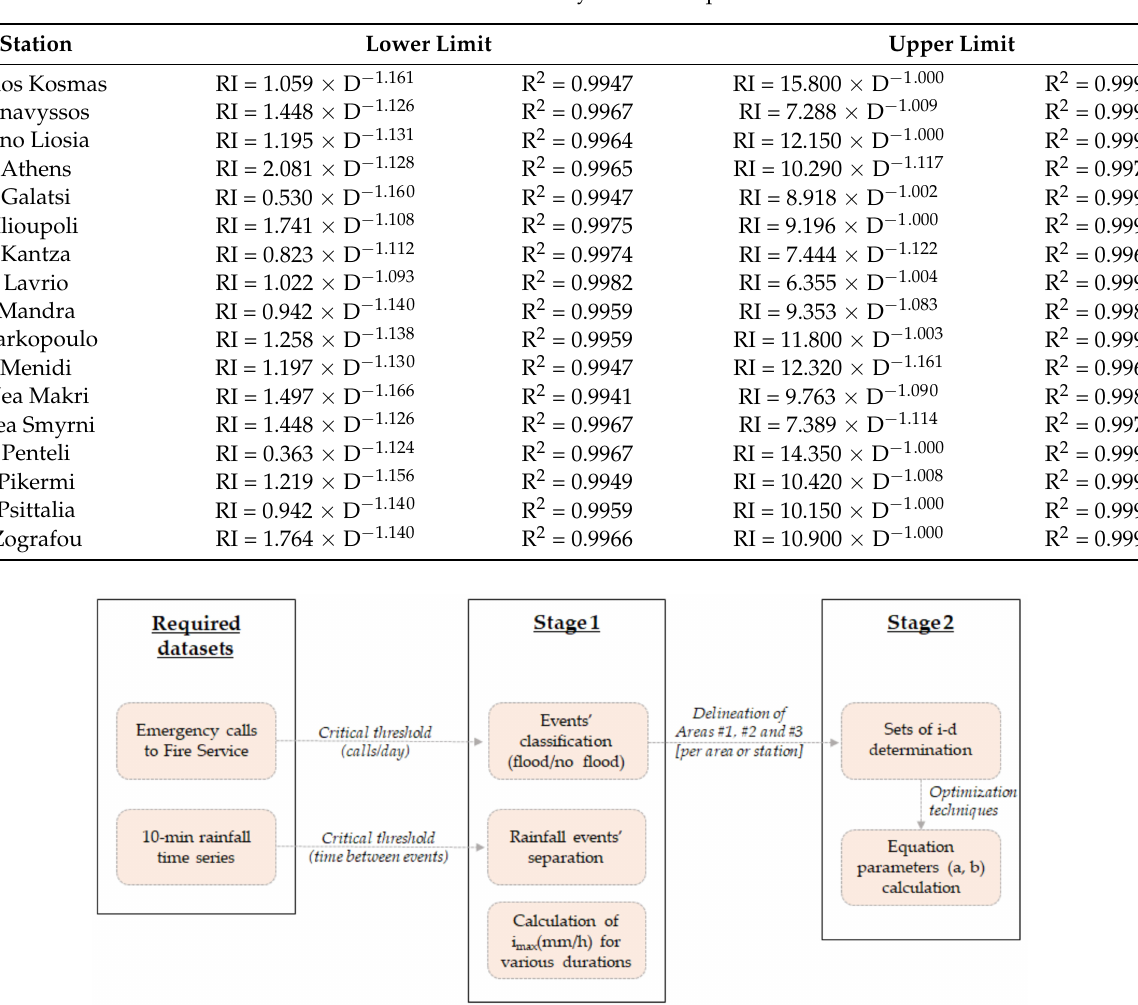
Table 2. Maximum rainfall intensity-duration equations.